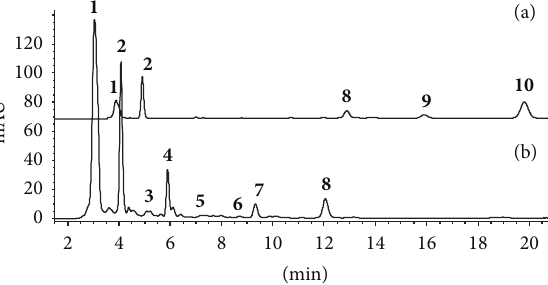
Figure 3: DAD chromatograms, recorded at 660nm (a) and 476 (b), of sediment extract from Edmondson Point lake obtained using gradient elution with MeOH-MeCN (0min 70 :30; 15min 80 :20, 20 min 90: 10); peak numbers correspond to pigments listed in Table